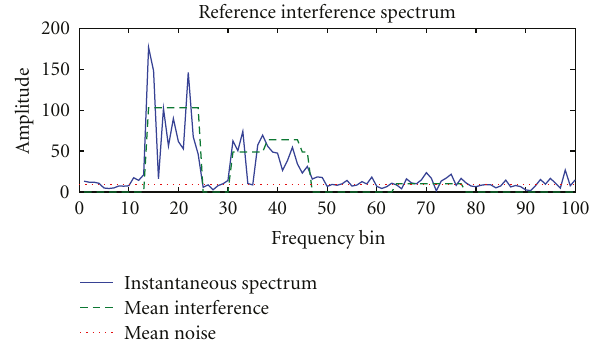
Figure 2: An example received interference sample vector spec- trum. The instantaneous spectrum of the sample vector is shown in comparison to the ensemble mean spectrum that would be obtained by averaging many sample vectors with identical interference statistics. The ensemble mean noise root variance also is shown for reference. This example sample vector is used as a reference to illustrate the detection methods described in Sections 3 to 5. Note the low power interferer occupying frequency bins 64 to 77.